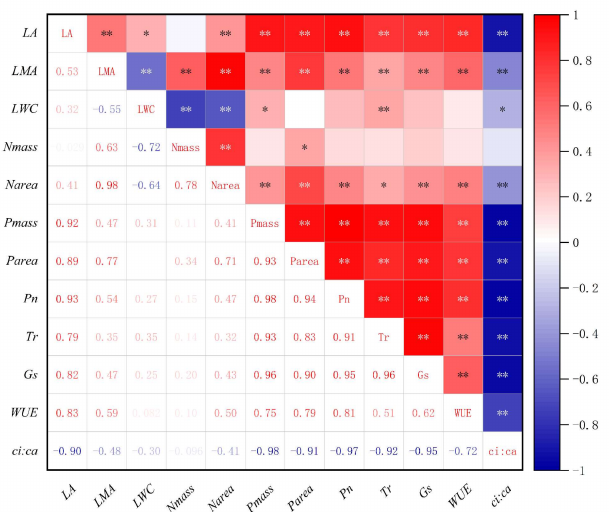
Figure 6. Correlation analysis of leaf functional traits of male and female plants of H. tibetana at different elevations. Note: ** indicates correlation is significant at p < 0.01 level; * indicates correlation is significant at p < 0.05 level.